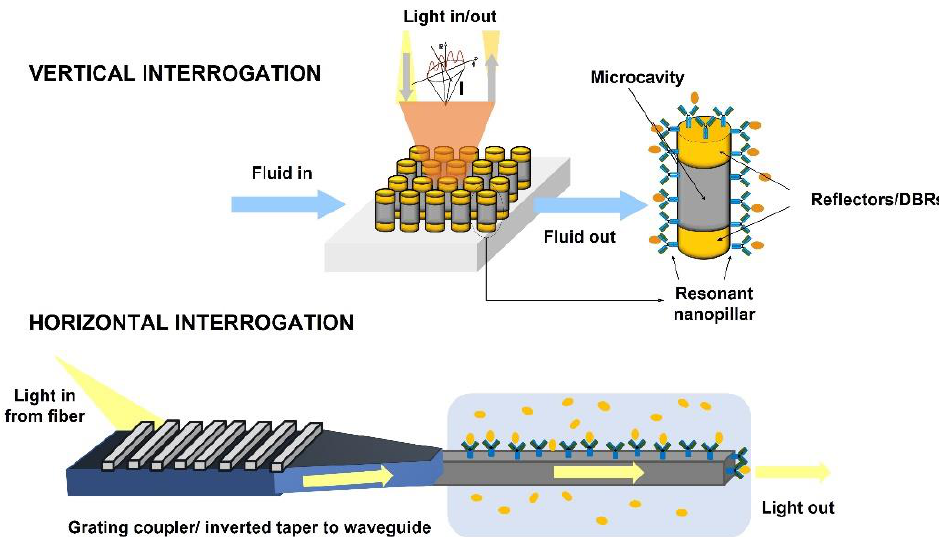
Figure 6. Schematic diagram of optical Interrogation, vertical ( top ) and horizontal ( bottom ). Depiction of the vertically characterized sensor based on an array of resonant nanopillars ( top , from Casquel. R, Doctoral Thesis (2012) [35]). Depiction of the horizontally interrogated sensor ( bottom ). The light is coupled from the fibre to the waveguide by using a combination of a grating coupler and an inverted taper.